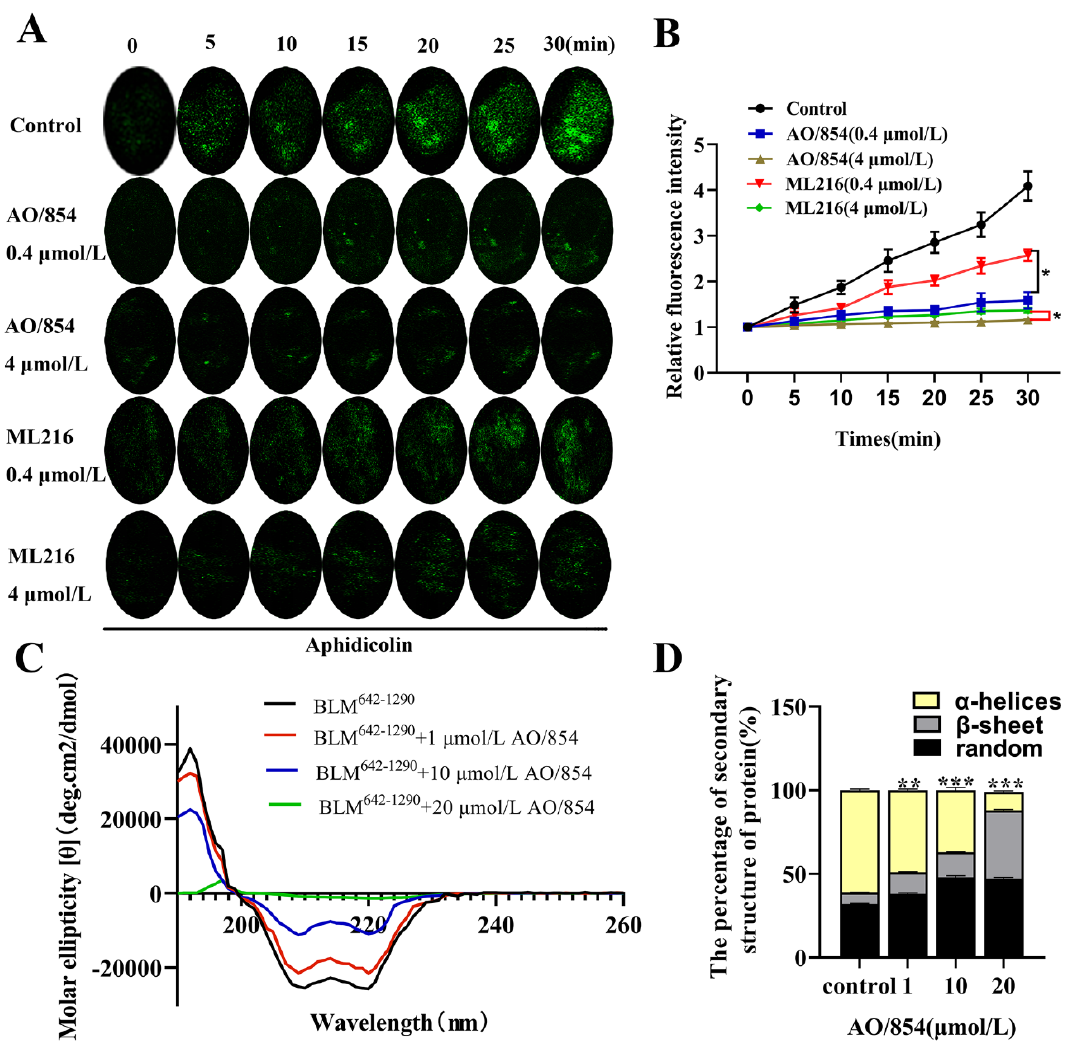
Figure 3. Effect of BLM inhibitors on intracellular unwinding function and BLM secondary structure. ( A ) Effect of AO/854 or ML216 on DNA helicase activity in vivo. Live cell microscopy setup for helicase activity measurements. Cells were transfected with RPA (green) as indicated 24 h before imaging. Representative confocal time ‐ lapse microscopy images of aphidicolin ‐ treated cells in 30 min, showing RPA accumulation from replication foci (control). After AO/854 or ML216 treatment, the accumulation of RPA was weakened. ( B ) AO/854 had a stronger inhibitory effect on DNA hel ‐ icase activity in vivo. RPA accumulation at replication foci, as a proxy for helicase speed, was meas ‐ ured for each time point, normalized to the GFP channel values at time point 0 (pretreatment), and the coefficient of variation of the GFP ‐ channel intensities was plotted for each time point. Data rep ‐ resent the average of three independent experiments. Error bars: SD (* p < 0.05). ( C ) CD spectra of BLM and their changes after binding to different concentrations of AO/854. ( D ) Protein secondary structure contents of AO/854 (1, 10, and 20 μ mol/L) ‐ treated BLM 642 − 1290 groups compared with DMSO ‐ treated group (control group). Data represent the average of three independent experiments. Error bars: SD. (** p < 0.01, *** p < 0.001).